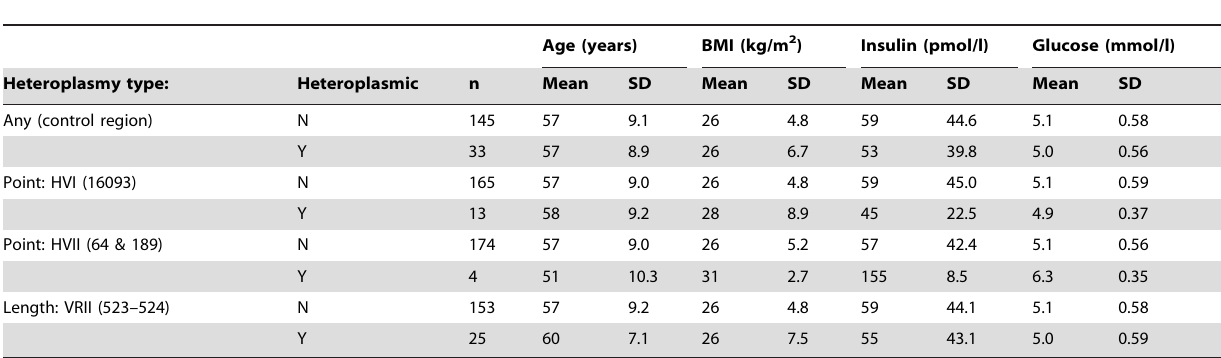
Table 1. Mean age, body mass index (BMI) and insulin and glucose fasting serum levels for heteroplasmic and non-heteroplasmic individuals (heteroplasmy measured in buccals